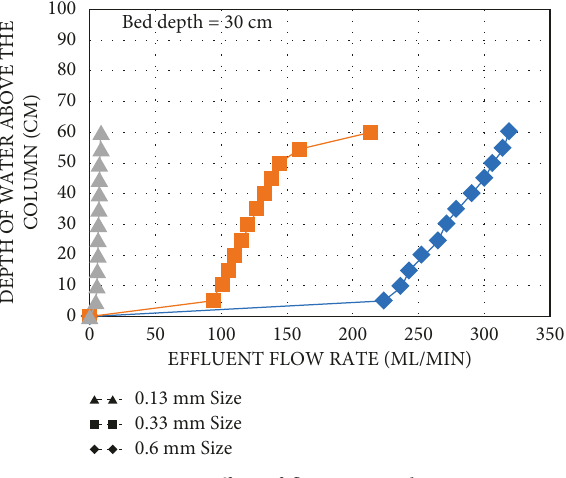
Figure 3: Effect of flow rate analysis.